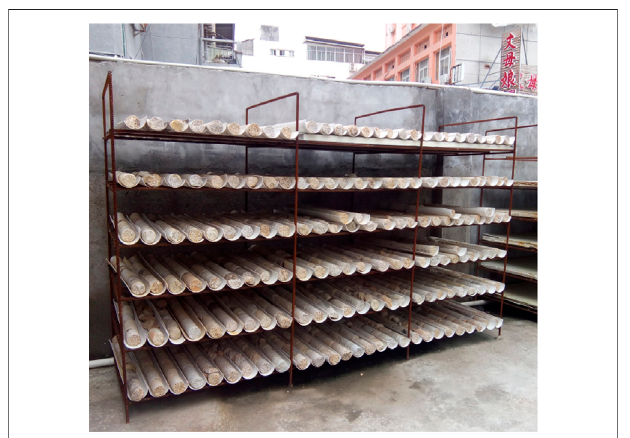
FIGURE 18 | Rock sample collection